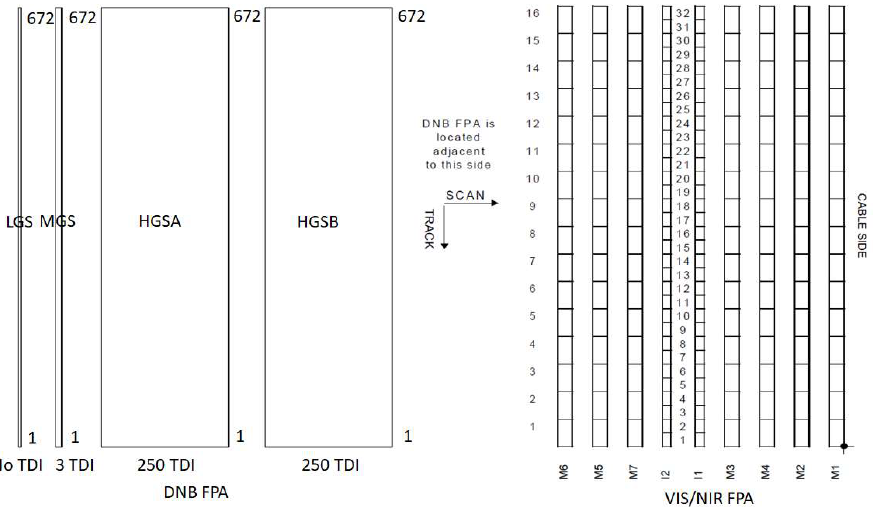
57 Figure 1. S-NPP VIIRS DNB and visible (VIS)/near-infrared (NIR) Focal Plane Assembly (FPA)